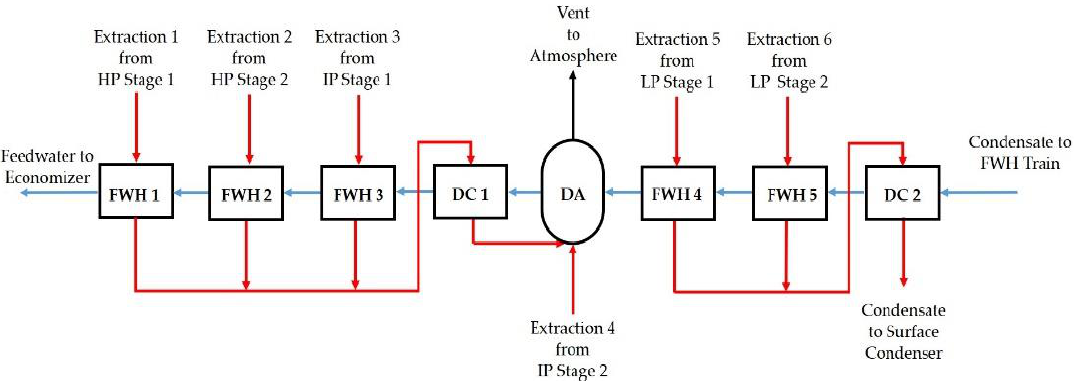
Figure 2. Feedwater Pretreatment and Heating Section Block Flow Diagram.